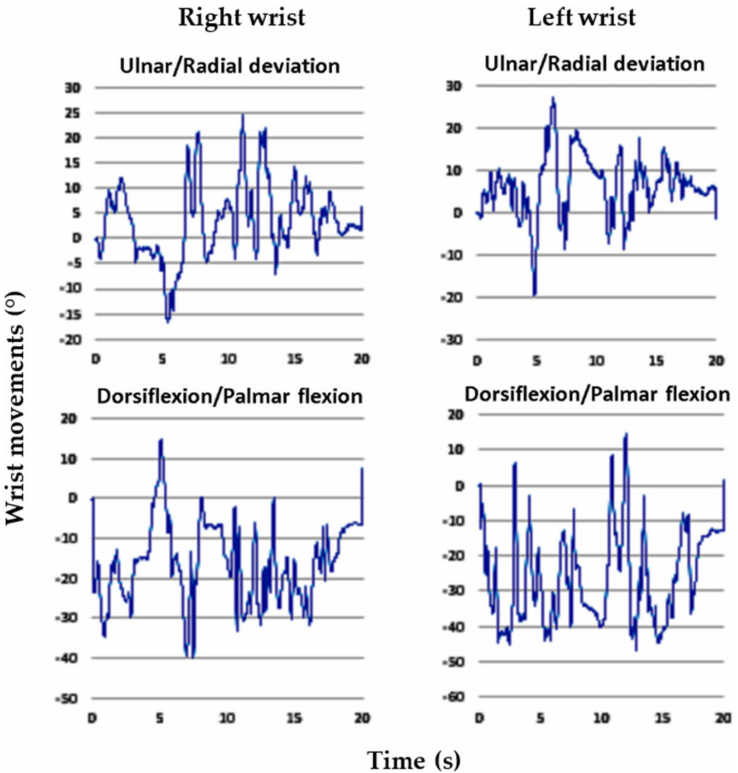
Figure 6. Wrist posture alterations during dough